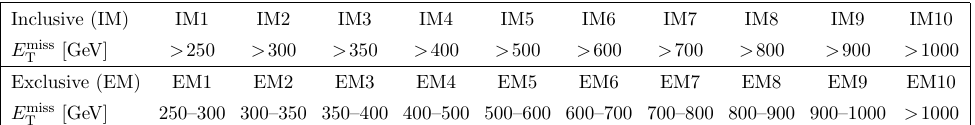
T > 1 TeV, whereas the EM10 T shape in data and simulation, as T